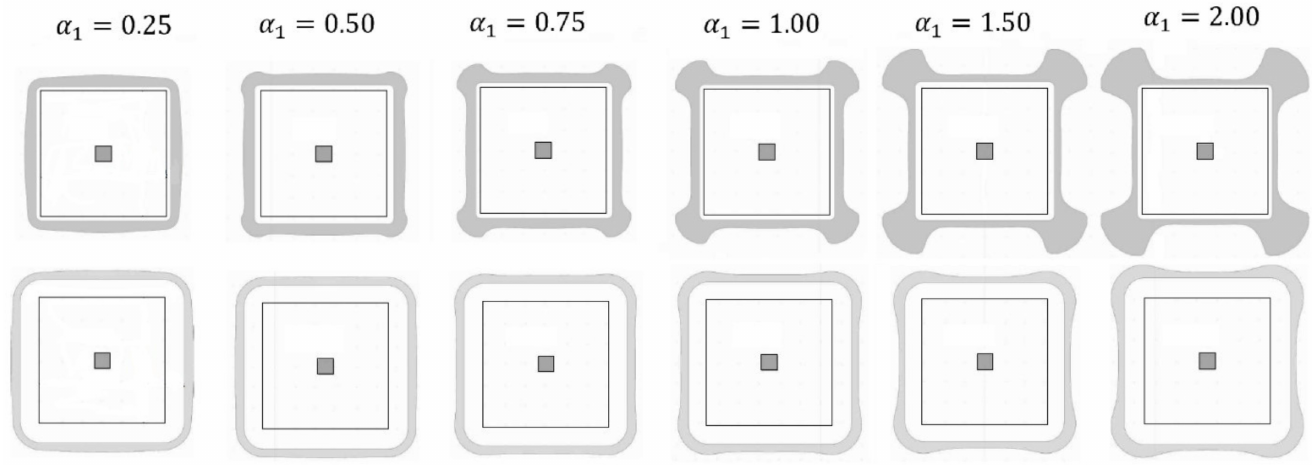
Figure A4. Graphs of the shear forces in the control perimeter depending on the shear cap height—200 cm shear cap width (c/d = 10).